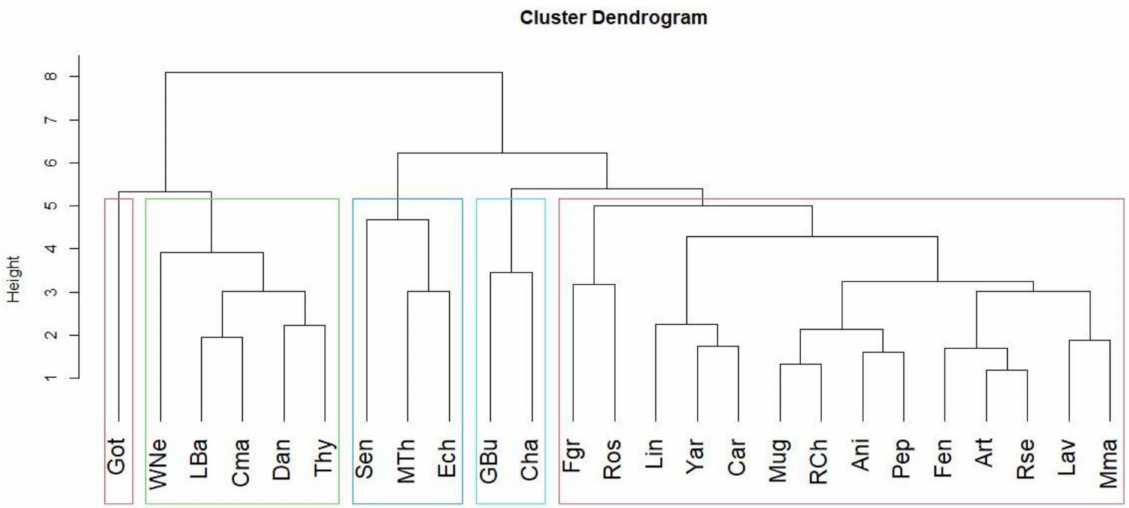
Figure 1. Dendrogram, obtained by the Ward.D2 method [21], from 25 plant samples, showing 5